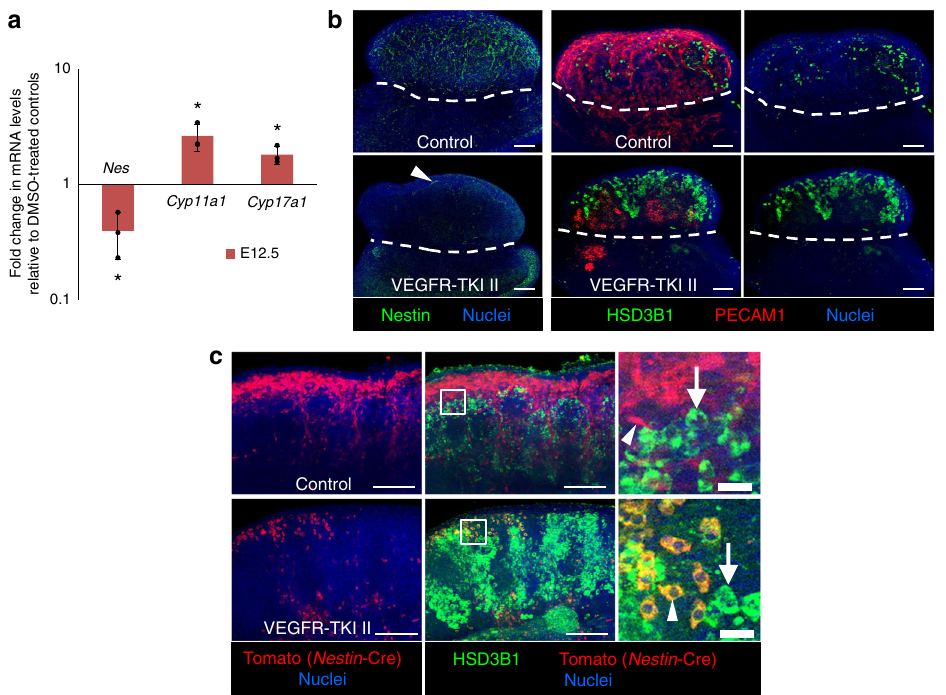
Fig. 5 Vascular disruption induces excessive differentiation of Nestin-positive cells. a qPCR analysis showing fold change in expression of Nes ( Nestin ; interstitial progenitor gene), Cyp11a1 , and Cyp17a1 (differentiated FLC genes) in E12.5 fetal testes cultured for 48 h in the presence of VEGFR-TKI II (1.8 µ g/ µ l) relative to DMSO-treated controls. Data are presented as the mean ± SD of 3 independent biological replicates ( n = 3 litters, ≥ 5 gonads/litter). * P < 0.05 (two-tailed Student t -test). b Immuno fl uorescence images of E12.5 fetal testes cultured for 48 h in the absence (top row, DMSO Control) or presence (bottom row) of VEGFR-TKI II (1.8 µ g/ µ l). Following vascular depletion, there was an increase in the number of HSD3B1-positive cells and a decrease in the number of Nestin-positive progenitors compared to DMSO-treated control gonads. Arrowhead in ( b ) shows some remnant Nestin expression in peritubular cells of vascular-depleted gonads. c Immuno fl uorescence images of E12.5 Nestin -Cre; Rosa- Tomato testes cultured for 48 h in the absence (DMSO Control, top row) or presence of VEGFR-TKI II (1.8 µ g/ µ l, bottom row). In DMSO-treated control gonads, Tomato-positive cells were spindle- shaped (top row, arrowhead) and mutually exclusive from HSD3B1-positive Leydig cells (arrows), while in vascular-depleted gonads, Tomato-positive cells started to express HSD3B1 (bottom row, arrowhead) and are round in shape, indicating their (premature) differentiation into mature FLCs following vascular depletion. Thin scale bars, 100 μ m, thick scale bars, 10 μ